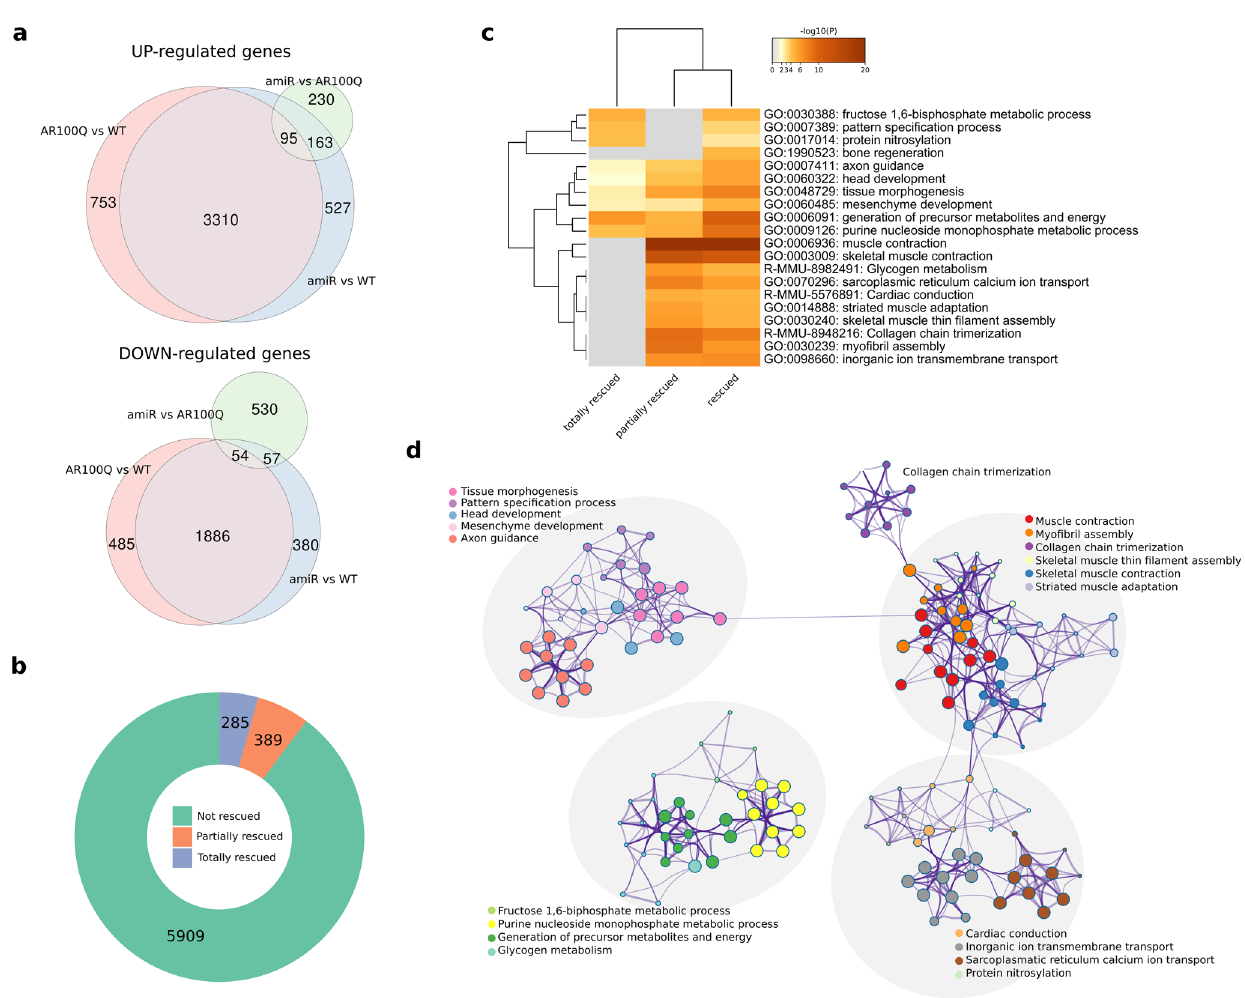
Fig. 7 | Silencing of Lsd1 and Prmt6 modi fi es gene expression in SBMA muscle. a Venn diagrams showing intersection of differentially expressed genes (top, upregulated; bottom, downregulated; absolute fold-change >4 and adjusted p <0.01) obtained by comparing control (AR100Q) versus amiR-treated SBMA mice; AR100Q versus WT mice; or amiR-treated versus WT mice. b Ring plot showing the number of differentially expressed genes in AR100Q versus WT mice from differential expression analysis and relative proportions of totally and